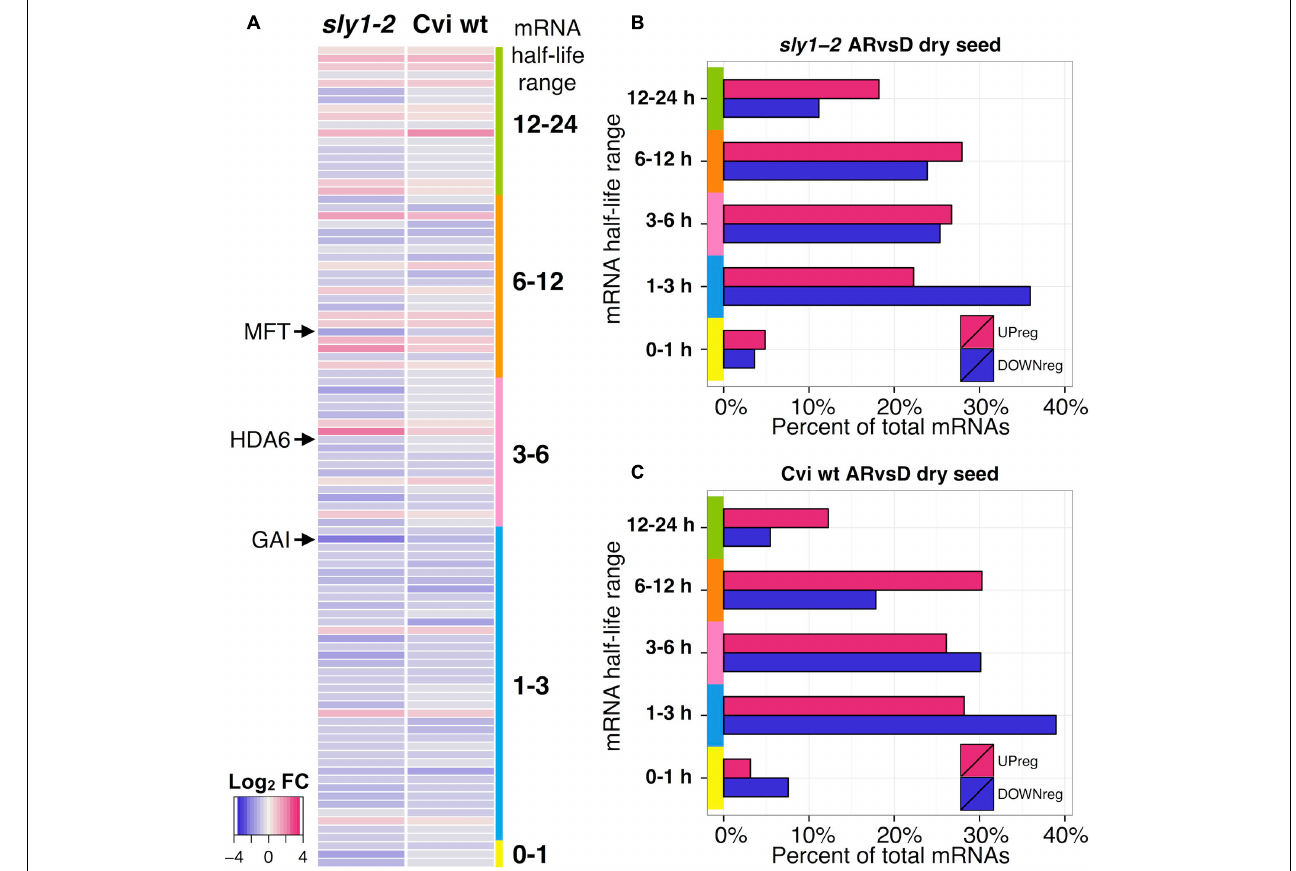
FIGURE 7 | Transcriptome differences categorized based on inherent mRNA stability. (A) Heat map of genes differentially regulated in dry seeds with after-ripening of both sly1-2 and Cvi wt. Genes are plotted in order of high to low mRNA stability determined based on the half-life scores from Narsai et al. (2007). (B,C) Plots of fractions of after-ripening-up- and down-regulated genes in each half life range stability category. (B) For sly1-2 dry seed transcriptome changes. (B) For Cvi dry seed transcriptome changes. There was a correlation of higher stability with up-regulation and lower stability with down-regulation in dry seed datasets. Both datasets had few genes with half-life in the 0–1 h